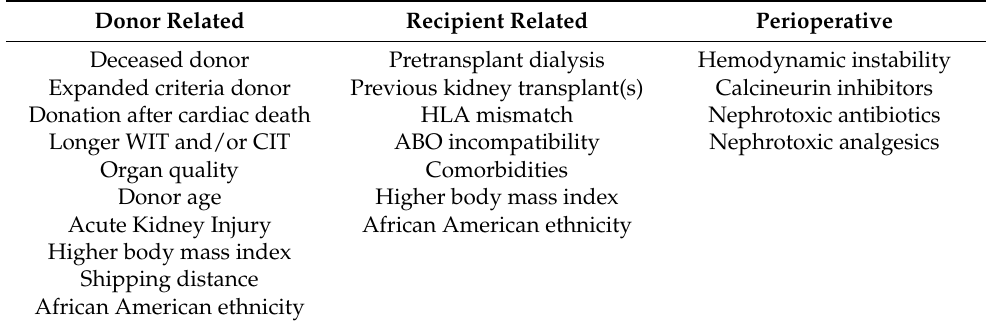
Table 1. Factors associated with DGF development. CIT, cold ischemia time; HLA, human leukocyte antigens; WIT, warm ischemia